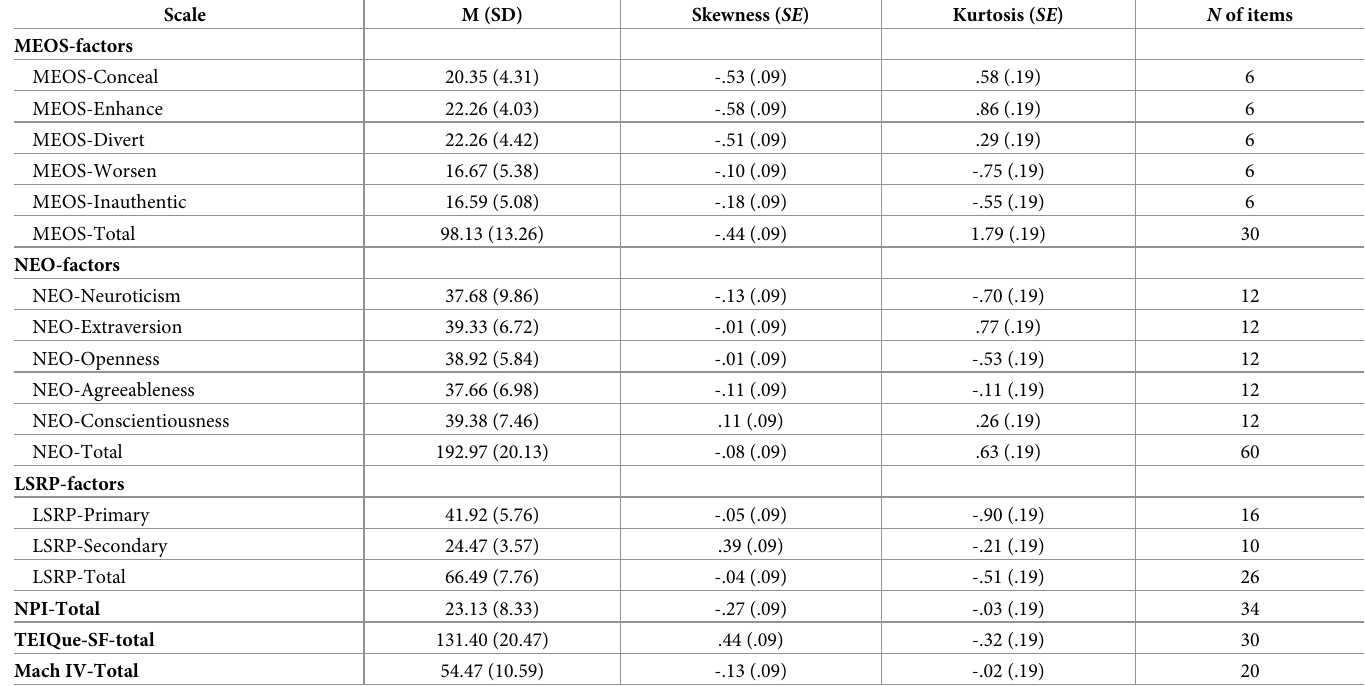
Table 1. Means (SD), Skewness, and Kurtosis for the MEOS-SF. Scale